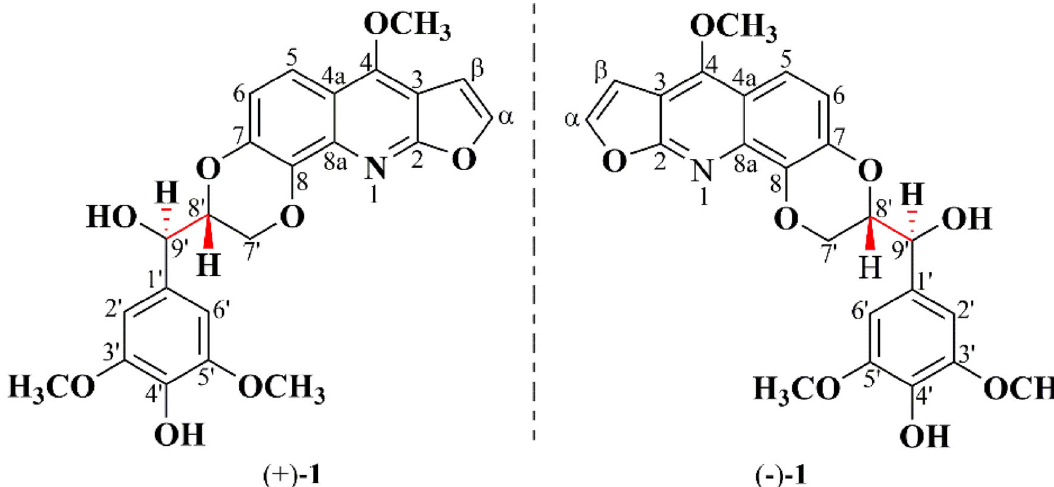
Fig. 1 Chemical structures of ( ± )-zanthonitidine A ( 1 )